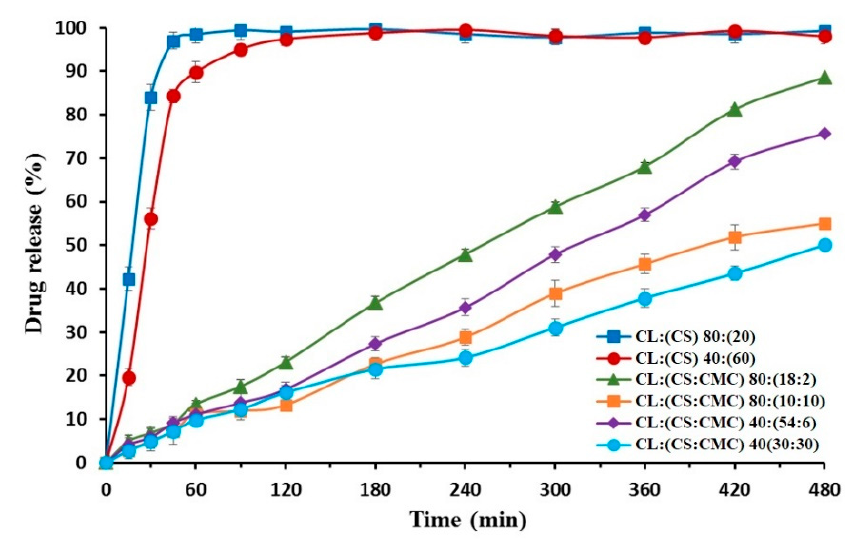
Figure 5. Release profiles of hydrogel tablets of CL:(CS) 80:(20) and 40:(60) and different PEC tablets of CL:(CS:CMC) 80:(18:2), 80:(10:10), 40:(54:6), and 40:(30:30) in acetate buffer (pH 4.2). The PEC tablets with high proportions of chitosan, CL:(CS:CMC) 80:(18:2) and 40:(54:6), showed high dissolution percentages at 8 h (98.62 ± 4.06 and 75.76 ± 3.62%, respectively).